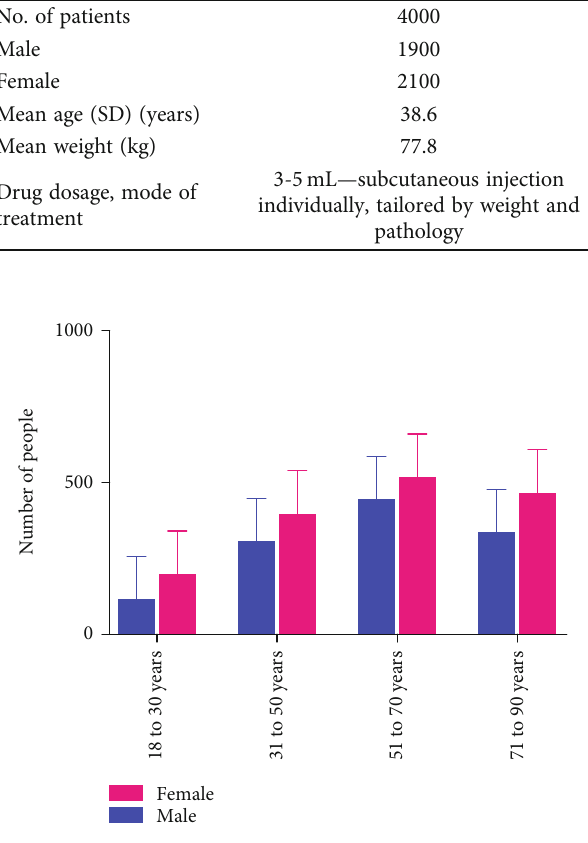
Figure 1: Distribution of population by age and sex. The bar graph shows the numbers of males and females in the 4-year age